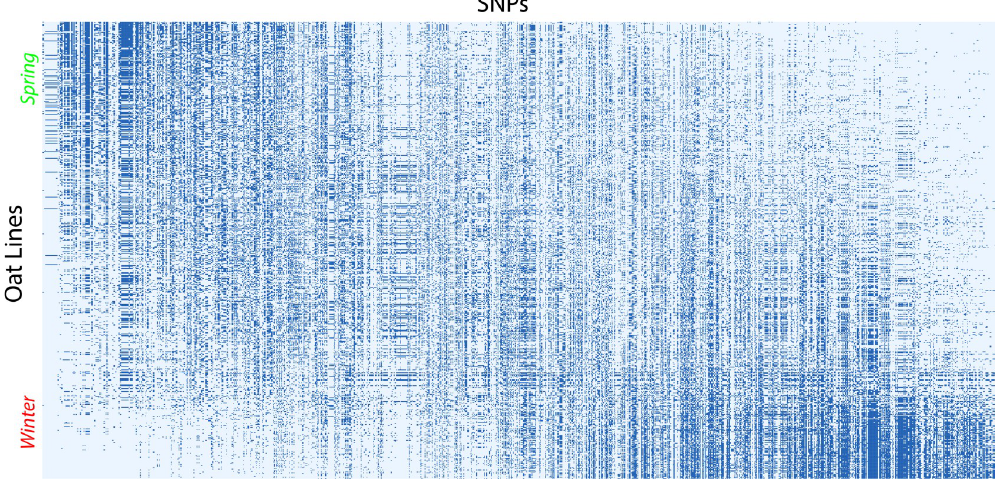
Fig 2. CA1 arranged matrix for 635 oat lines in rows and 1341 SNPs in columns. Spring oats are concentrated at the top of this matrix, and winter oats at the bottom. Correspondingly, SNPs at the left have high percentages of the rare allele in spring oats, and SNPs at the right have high percentages of the rare allele in winter oats.